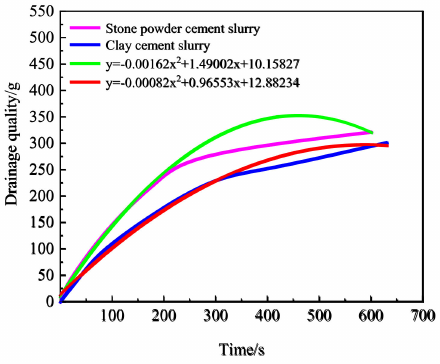
Figure 12. Relation curves of water drainage from the slurry with